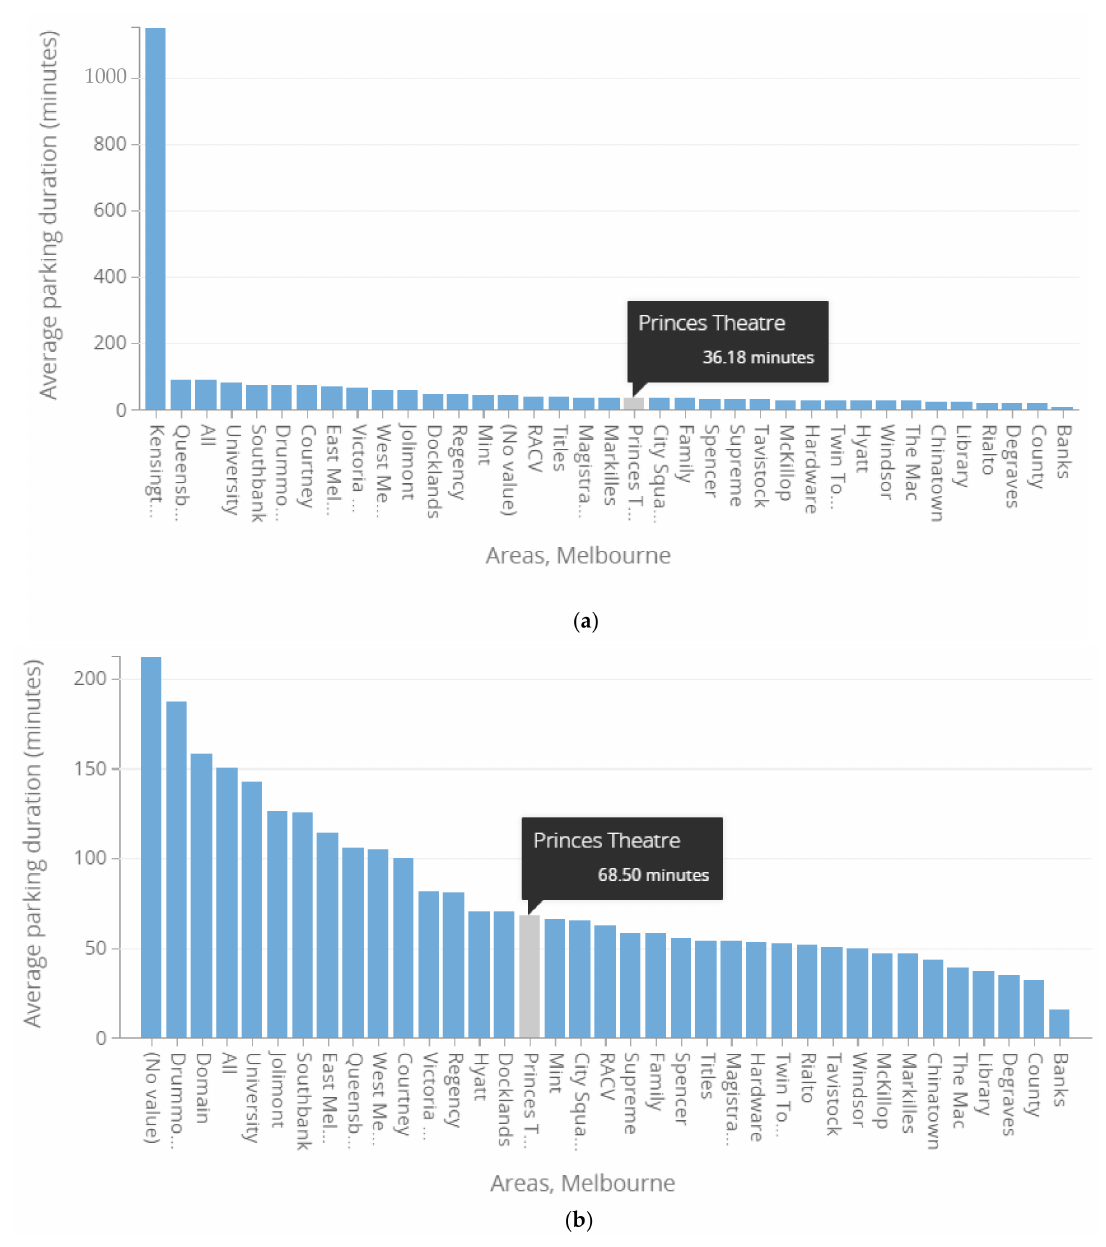
Figure 7. Bar graph representation, referring to the Princess Theatre area average parking duration between two periods: ( a ) 16 March to 26 May 2019 versus ( b ) 16 March to 26 May